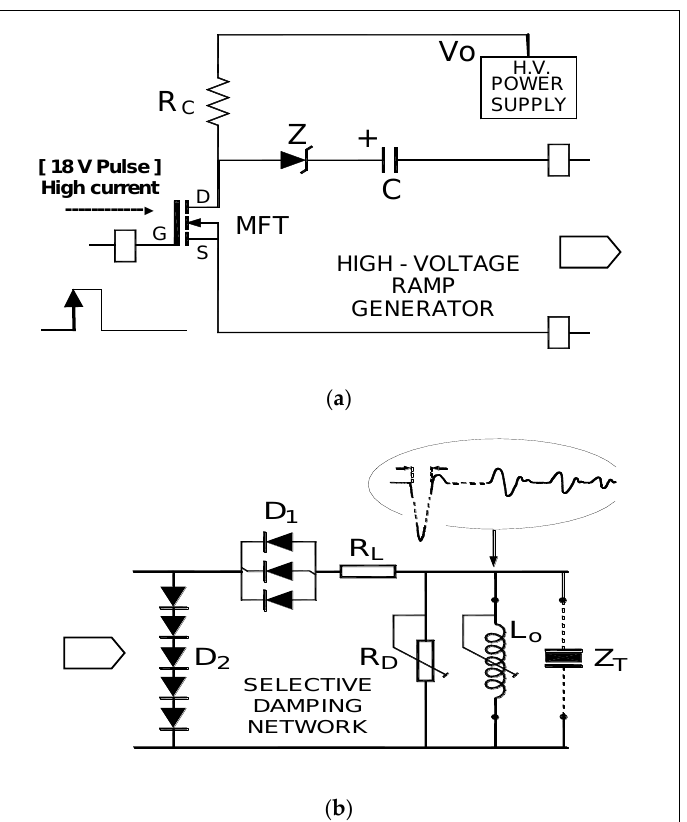
Figure 4. Circuital schemes for the blocks involved in Figure 3: ( a ) capacitive ramp generator and ( b ) pulse shaper and selective damping.